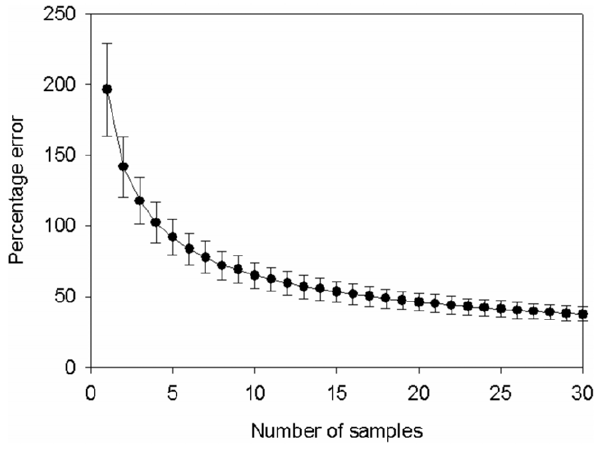
Figure 1. The mean ± 95% CI percentage error associated with estimates of mean biomass (g dry Wt m 2 2 ) at a site for a given number of samples.